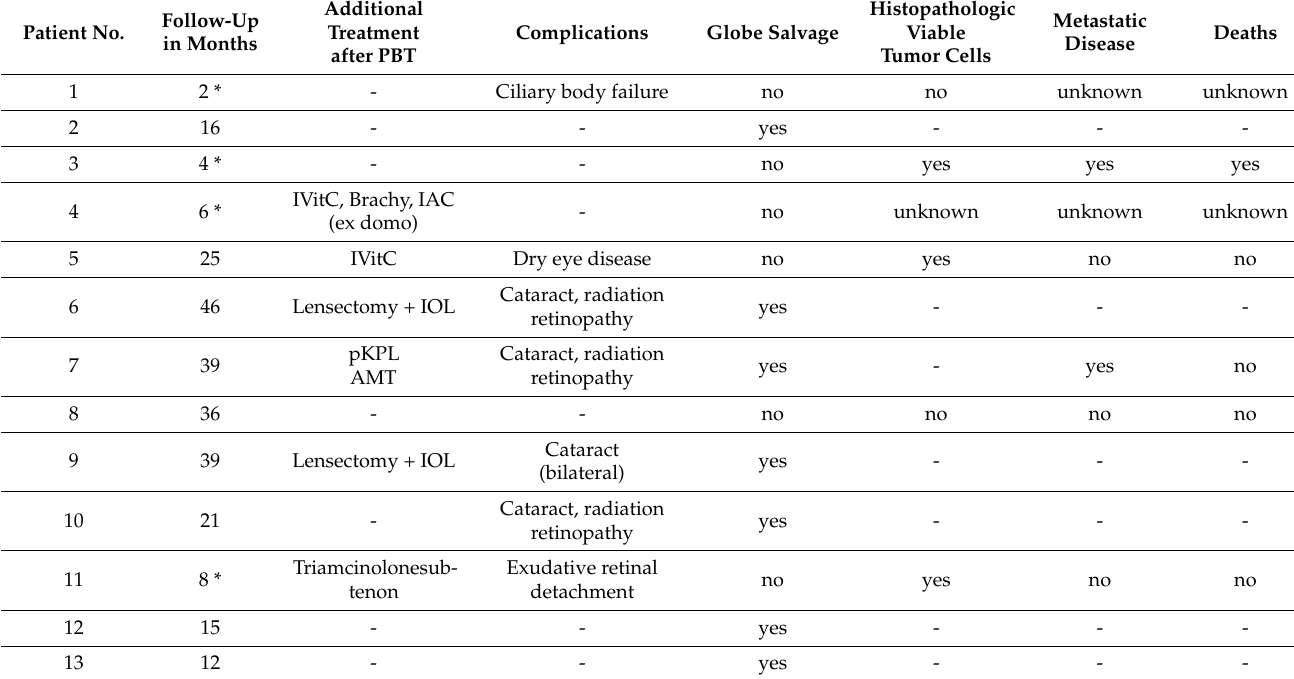
Table 2. Long-term follow-up with complications, additional treatment after PBT, globe salvage rate, long-term survival and histopathological workup, if applicable. Patient No.